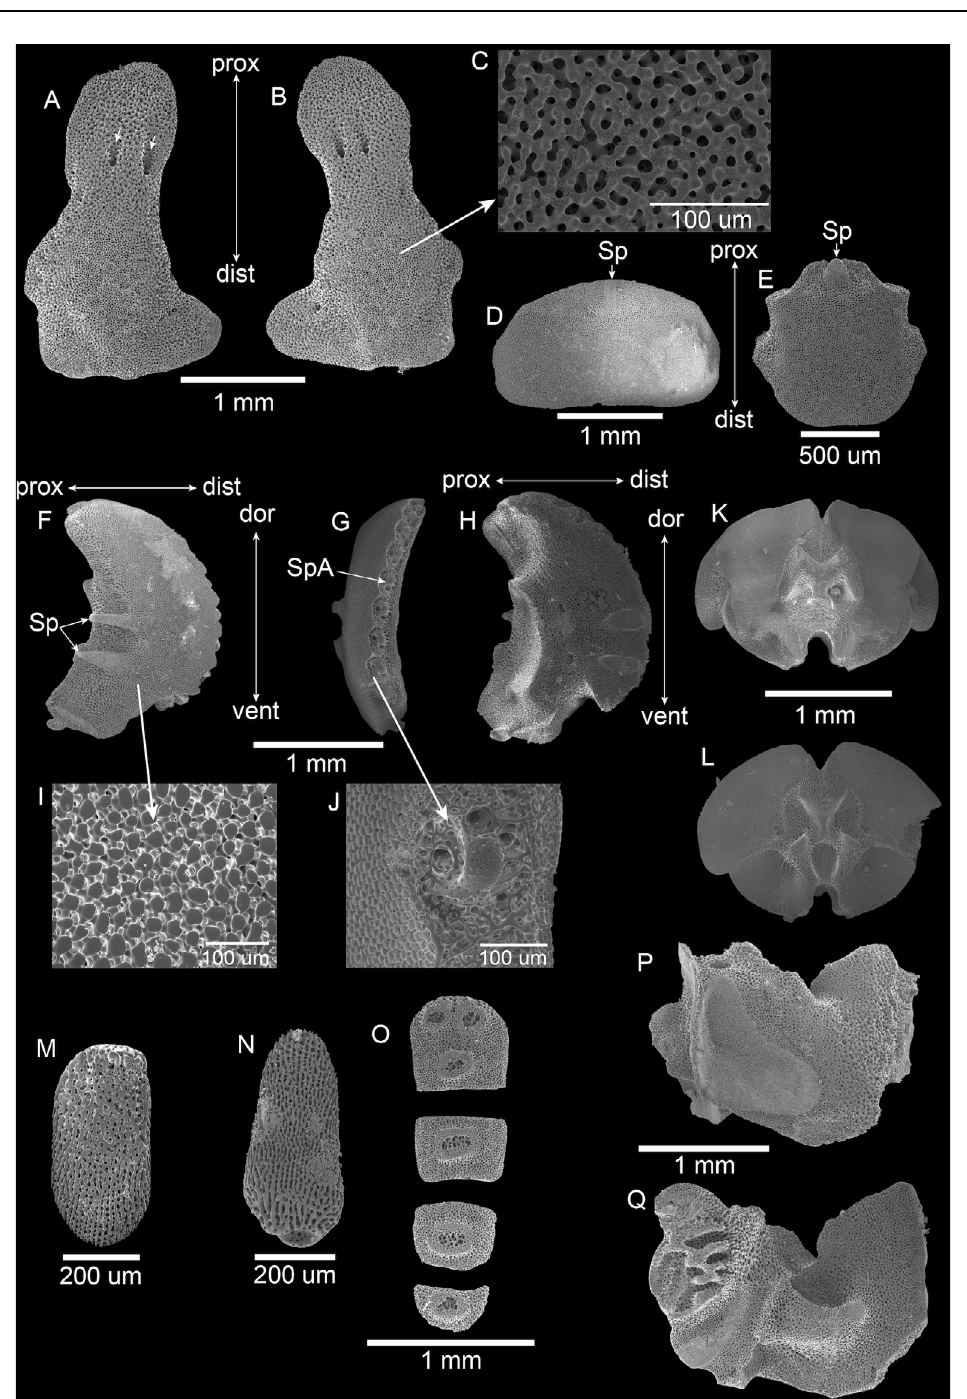
Fig. 2. SEM images of skeletal elements of Ophioderma hendleri sp. nov., paratype (ICML-UNAM 18323, DD = 15 mm). A–B . Radial shield (external view), deepest pores marked with arrows. C . Center of the distal portion of the radial shield, open meshed pores. D . Dorsal arm plate, with one spur. E . Ventral arm plate, with one spur. F . Lateral arm plate, external face, with two spurs and one condyle. G . Lateral arm plate, lateral face, with spine articulations. H . Lateral arm plate, internal face. I . Outer surface of the LAP (F) with finely meshed and polygonal knobs. J . Spine articulations with a weak sigmoidal fold and tilted lobes. K . Arm vertebra, distal face. L . Arm vertebra, proximal face. M . Tentacle scale. N . Arm spine. O . Dental plate fragments. P . Oral plate, abradial face. Q . Oral plate, adradial